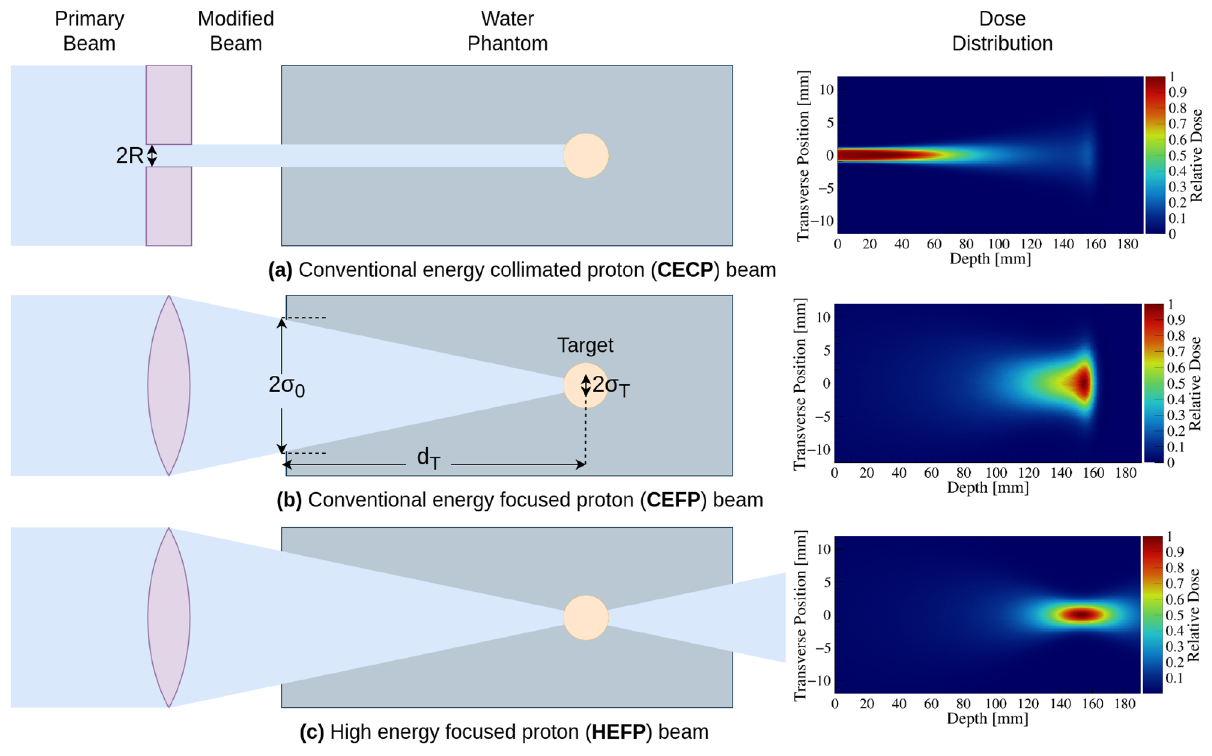
Figure 1. Principles of the beam shaping techniques discussed: ( a ) CECP, ( b ) CEFP, and ( c ) HEFP, shown schematically (left column) and the resulting normalized 2D dose profiles (right column). Also indicated is the meaning of the entrance beam size σ 0 , the target distance d T , the target spot size σ T , and the collimator radius R